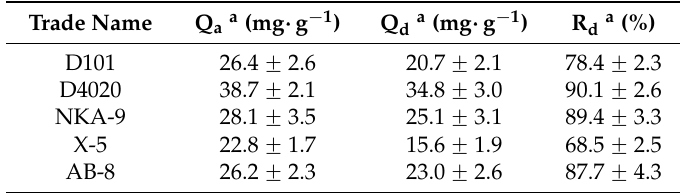
Table 1. Adsorption and desorption properties of five macroporous resins for total flavonoids in the crude flavonoid extracts of Scorzonera austriaca